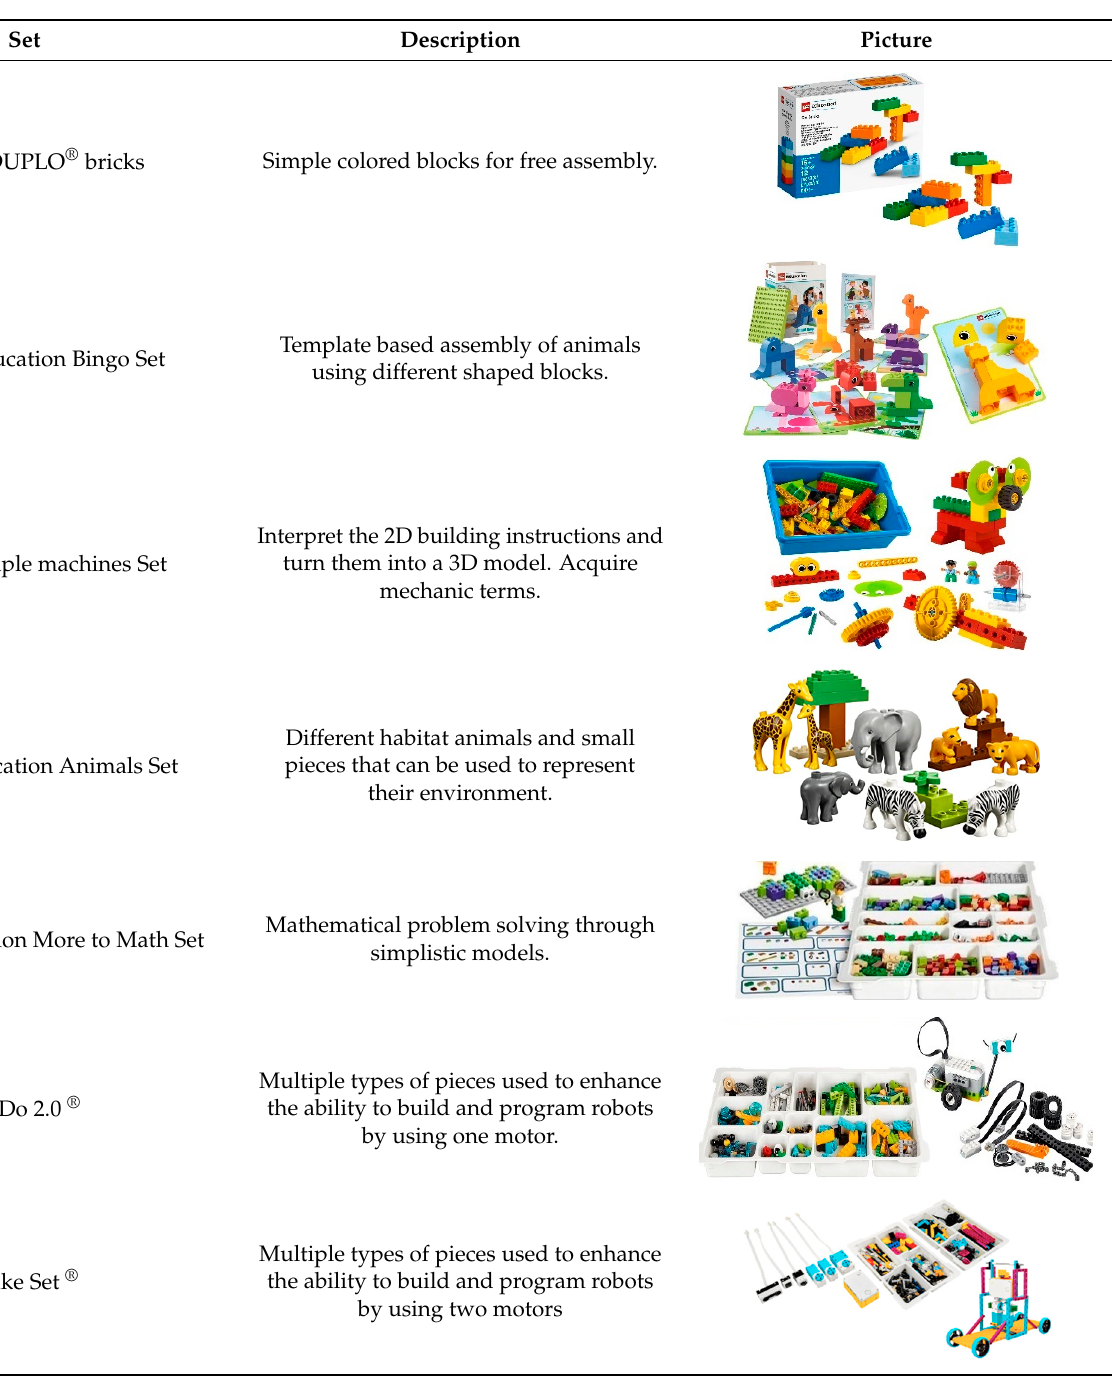
Table A1. Description table of the sets used for the habilitation.